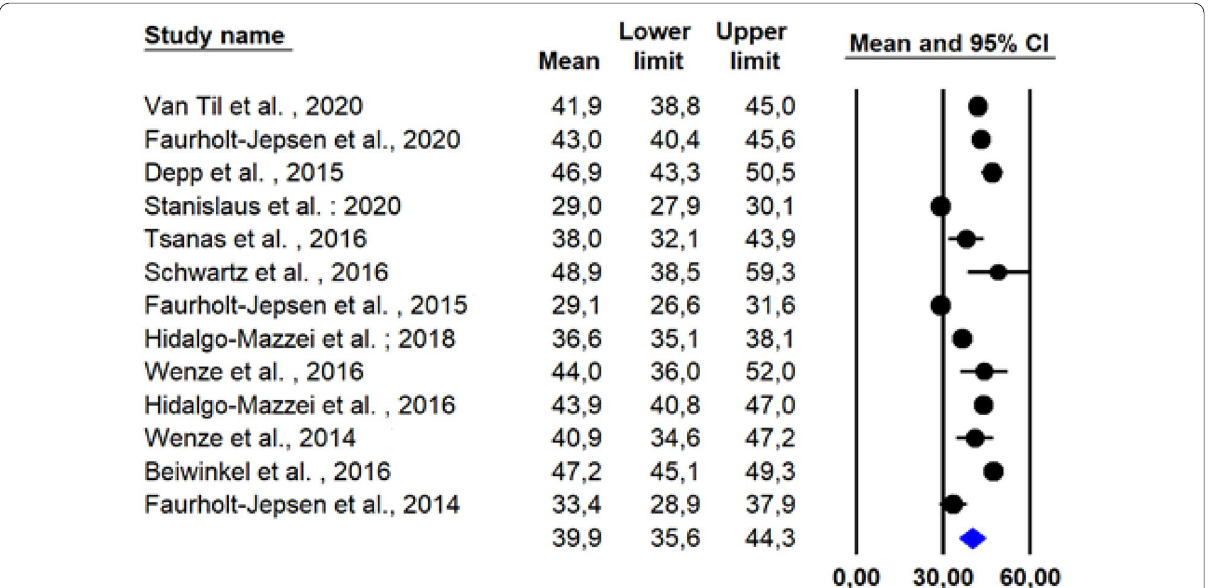
Fig. 2 Mean and standard‑deviation of age of participants in the included studies taking into account the between‑ and within‑study